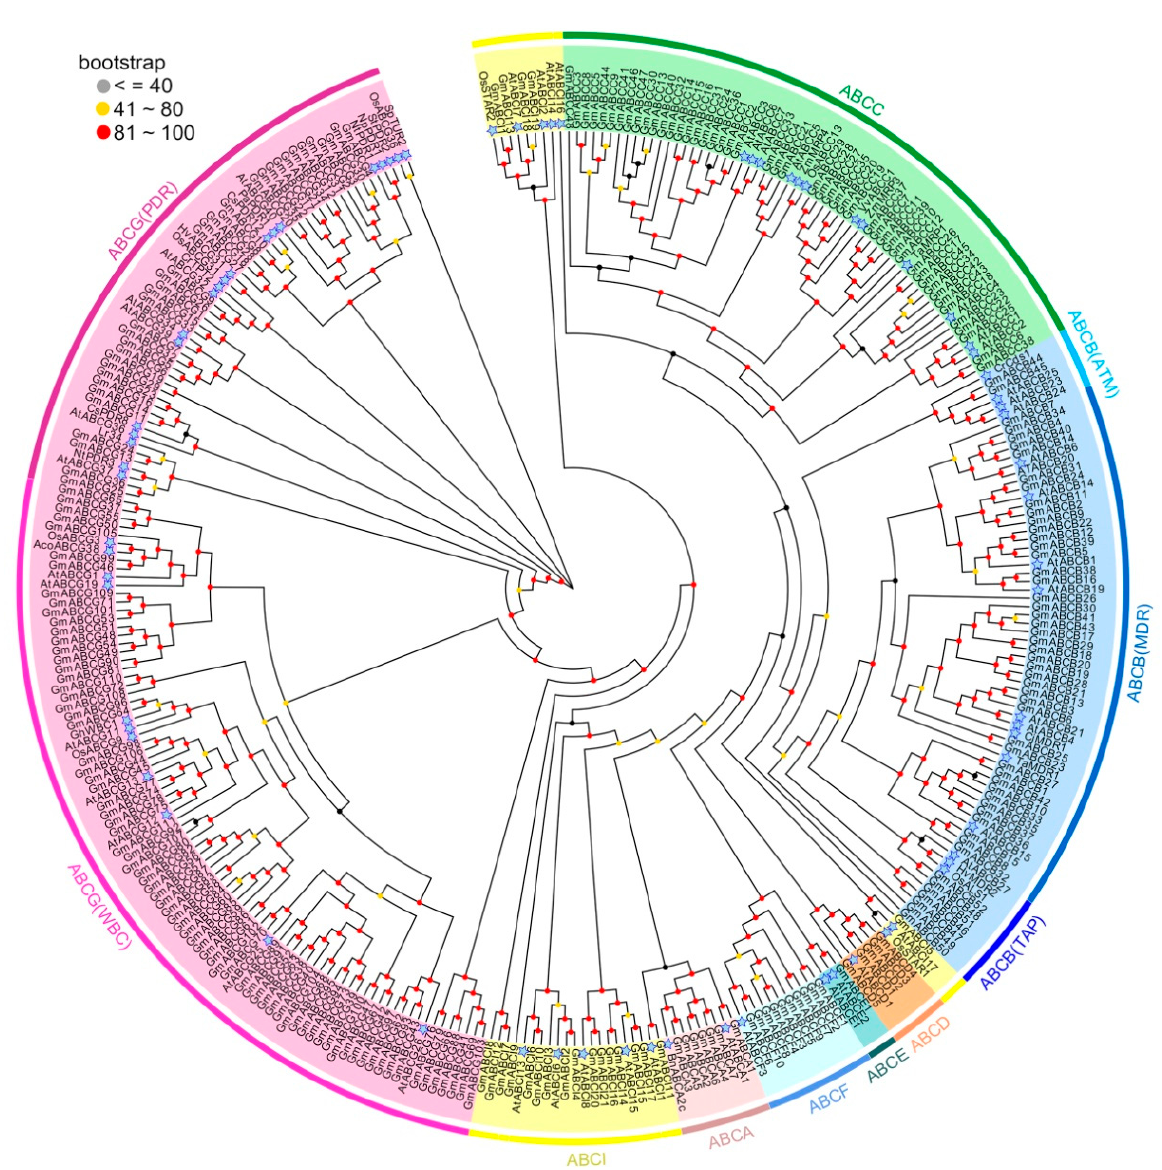
Figure 2. Phylogenetic tree of ABC transporter proteins from soybean. The unrooted phylogenetic tree was constructed by MEGA 7.0 using the maximum likelihood (ML) algorithm with 1000 bootstraps. Eight subfamilies are highlighted by different colors.